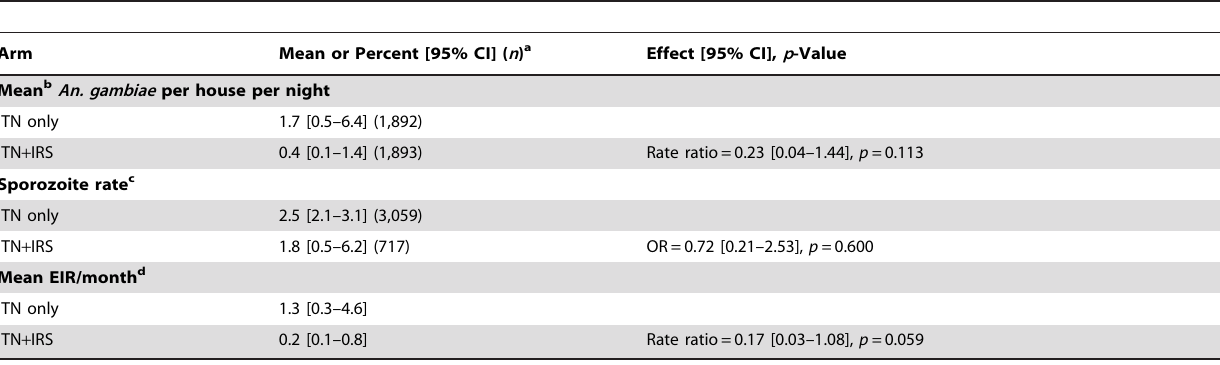
Table 6. Mean number of An. gambiae mosquitoes per household, sporozoite rate, and EIR in the ITN only and ITN + IRS arms during the post-intervention period, Muleba District, Tanzania,